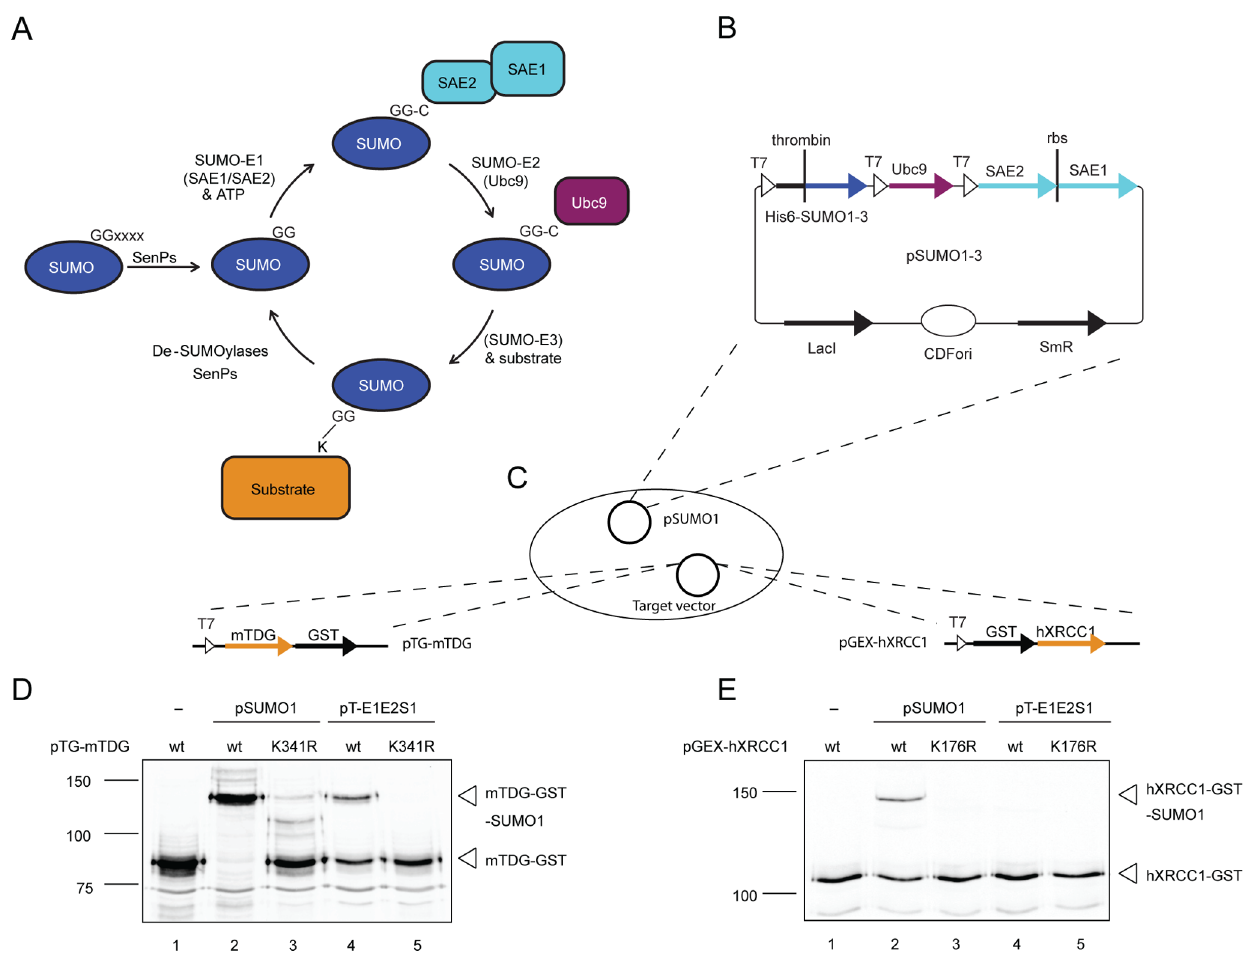
Figure 1. The pSUMO-based SUMOylation system modifies proteins in E.coli . ( A ) Scheme of the in vivo SUMO maturation, SUMO conjugation and deconjugation process (for detailed description, see ‘‘Introduction’’). ( B ) pSUMO vectors containing the humanized SUMOylation system consisting of N-terminally His 6 -tagged SUMO1, 2 or 3, the SUMO-conjugating enzyme E2 (Ubc9) and both subunits of the SUMO-activating enzyme (SAE1 and SAE2) as a cistronic expression unit with an internal ribosomal binding site (rbs). Expression of the respective cDNAs is under the control of a lac-repressor (LacI) regulated T7 promoter. ( C ) Scheme of the experimental setup of the pSUMO-based in-cell SUMO conjugation. E.coli BL21 cells were used containing pSUMO1 in combination with pTG-mTDG or pGEX-hXRCC1 plasmids were used for the co-expression of the complete SUMO system with C- and N-terminally GST-tagged mTDG and hXRCC1, respectively. Immunoblot analyses of mTDG ( D ) and hXRCC1 ( E ) SUMOylation in E.coli cells, expressing the SUMO target and the SUMO system from either the pSUMO1 or the pT-E1E2S1 plasmid (250 m M IPTG at 25 u C for 2 h). Co-expression of target proteins mutated in the SUMO acceptor sites of mTDG (K341R) and hXRCC1 (K176R) were included to assess the specificity of the SUMOylation